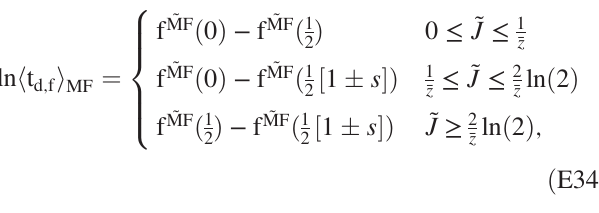
FIG. 17. Master scaling of mean dissolution and formation times per bond for finite clusters and in the thermodynamic limit. We show h t d ; f i for (a,b) cluster dissolution and (c,d) formation as a function of the coupling various cluster sizes (symbols), as well as the thermodynamic limit (lines) in the presence of an external pushing (a,c) and pulling (b,d) force. Symbols are evaluated with local equilibrium approximation (23) using Q BG 1 ∀ k (i.e., pure Glauber dynamics). The discrepancy between the lines and symbols is due to finite-size p k ¼